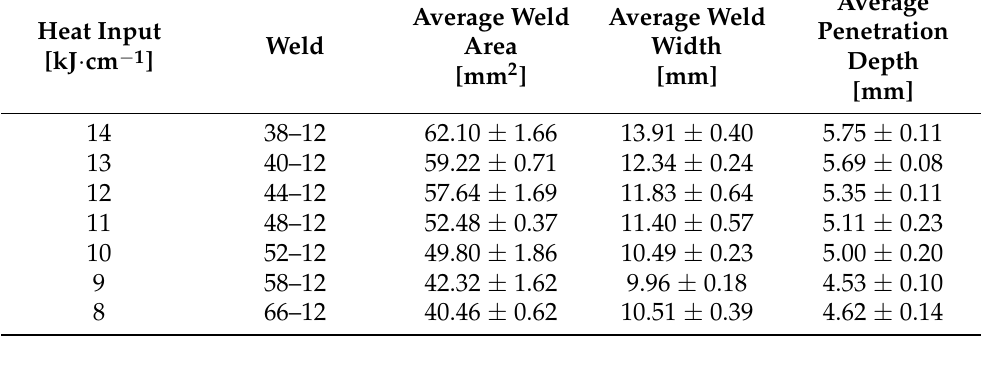
Table 4. Average values and standard deviations of the selected geometrical parameters.